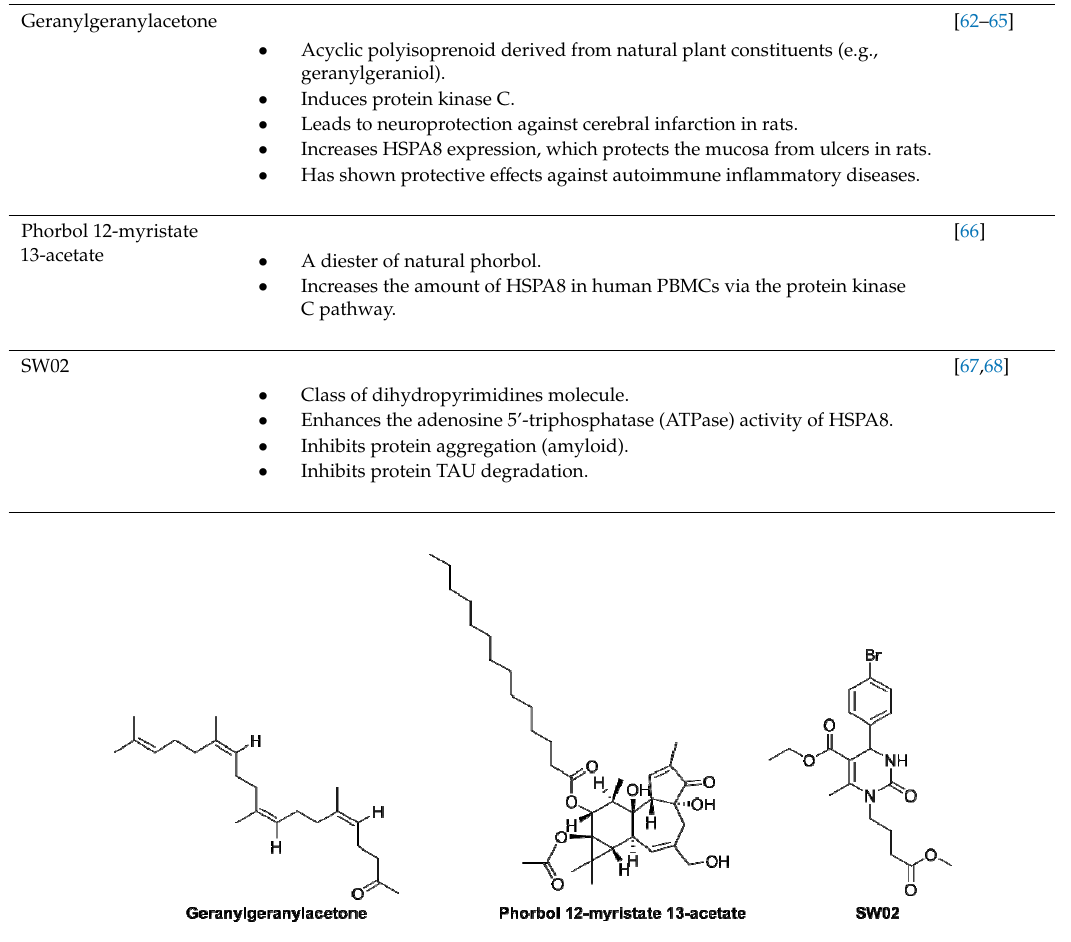
Table 2. HSPA8 activators.